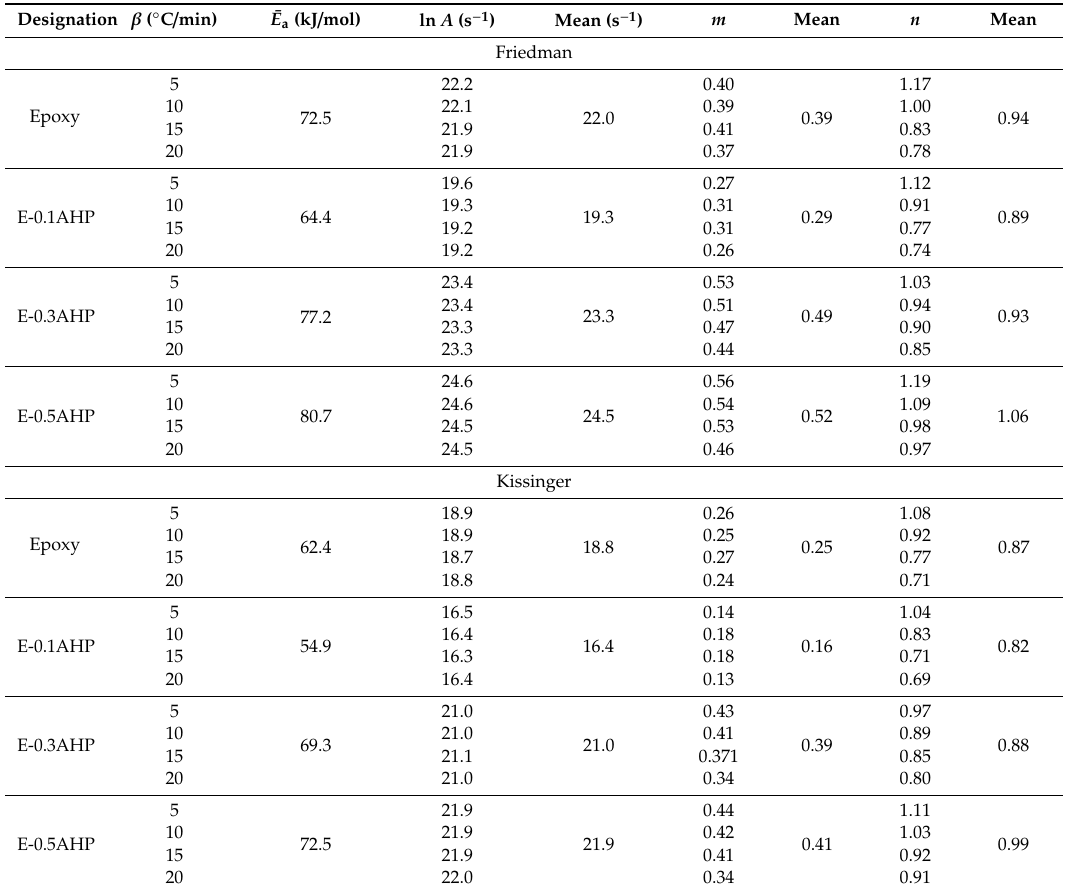
Table 3. The curing kinetic parameters of the samples based on Friedman and Kissinger